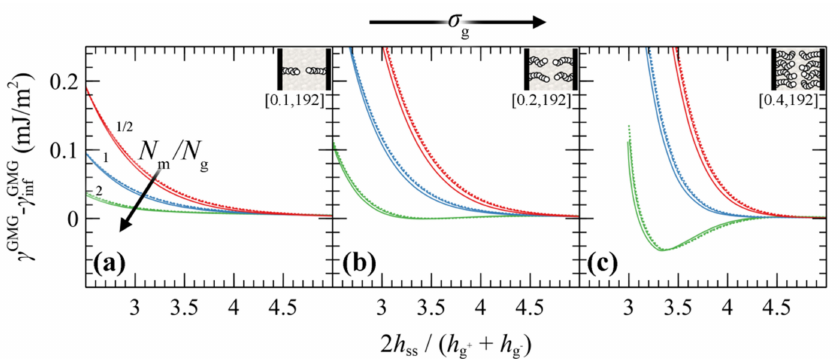
Figure 12. Potential of mean force against the reduced surface-surface distance of approaching symmetric grafted silica surfaces in a melt from the SL EoS for σ g set to ( a ) 0.1, ( b ) 0.2 and ( c ) 0.4 nm –2 and N g = 192. Colors correspond to evaluations for N m / N g = 1/2 (red), 1 (blue) and 2 (green), whereas different styles denote interfaces with low (solid lines), high (dashed lines) and perfect (dots) wetting.